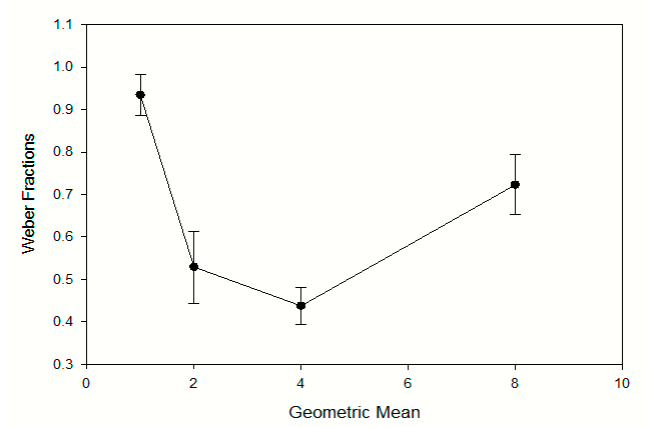
Figure 3. Weber fractions plotted as a function of the geometric mean across the four conditions. The error bars are the standard error of the mean.